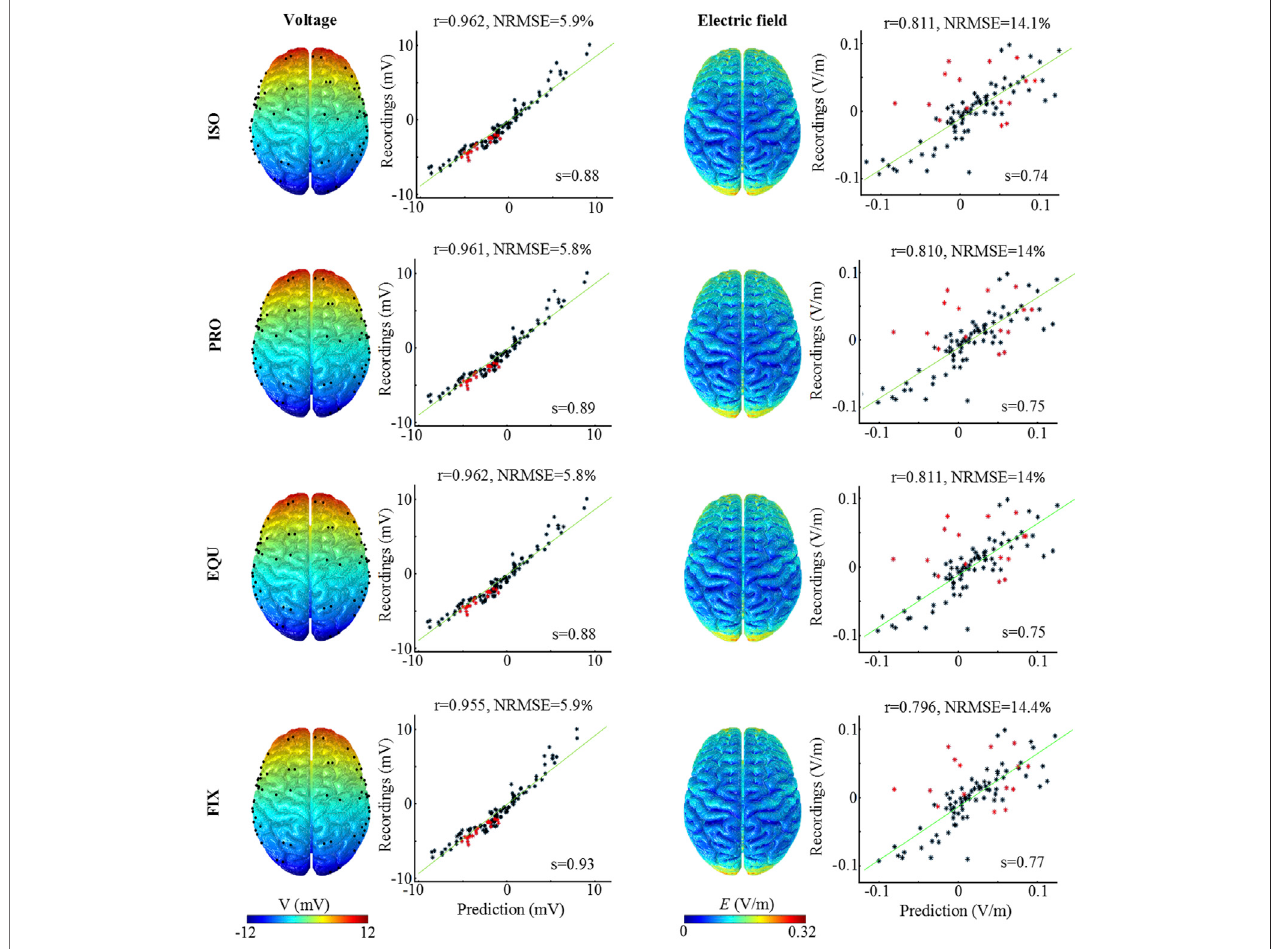
FIGURE 3 | Measured and predicted voltage and electric fi eld distribution. The fi rst and third columns illustrate the predicted voltage and electric fi eld distribution. The second and fourth columns show the correlation and difference analysis between measured and predicted values. The green line represents the fi tted line, and s denotes the slope of the fi tted line. r is Pearson ’ s correlation coef fi cient, while NRMSE represents the Normalized root-mean-square error (normalization is against the difference between the maximum and the minimum of the measured values, NRMSE in